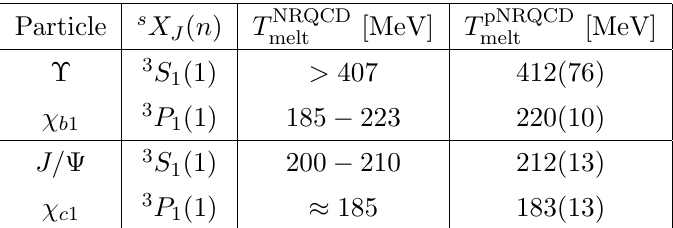
Table 5 . Estimates of the melting temperatures from lattice NRQCD (left column) compared to the predictions from tree-level pNRQCD based on the complex heavy quark potential from N f = 2 + 1 lattice